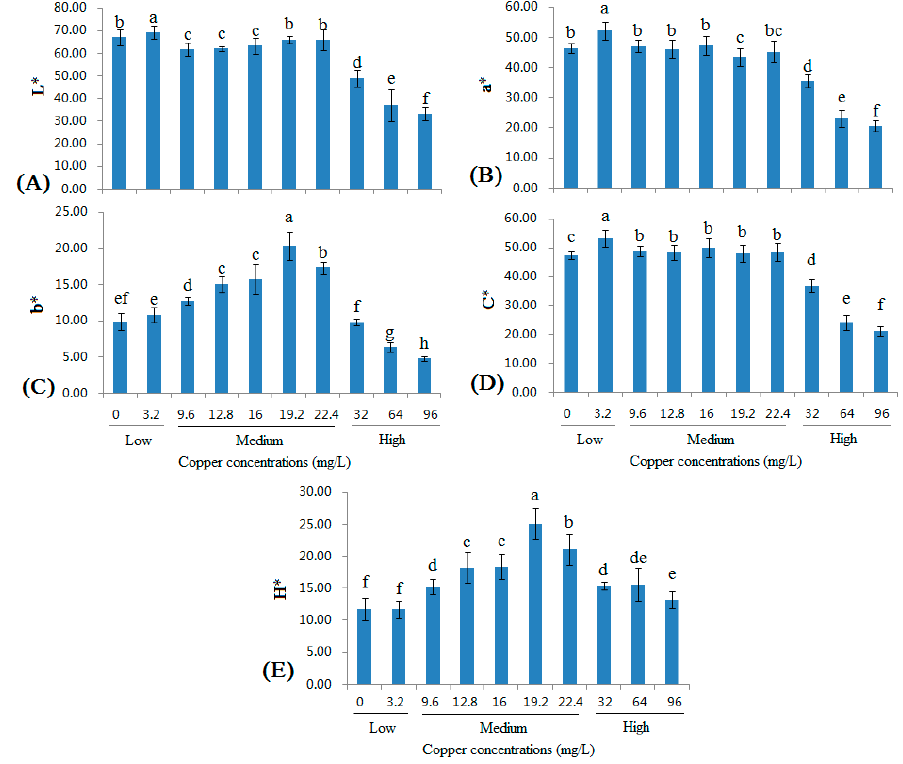
Figure 4. Changes in the L* ( A ), a* ( B ), b* ( C ), C* ( D ) and H* ( E ) values of wine with different copper concentrations. Different letters indicate statistically significant differences (Duncan’s multiple range test, p < 0.05) between samples with different copper